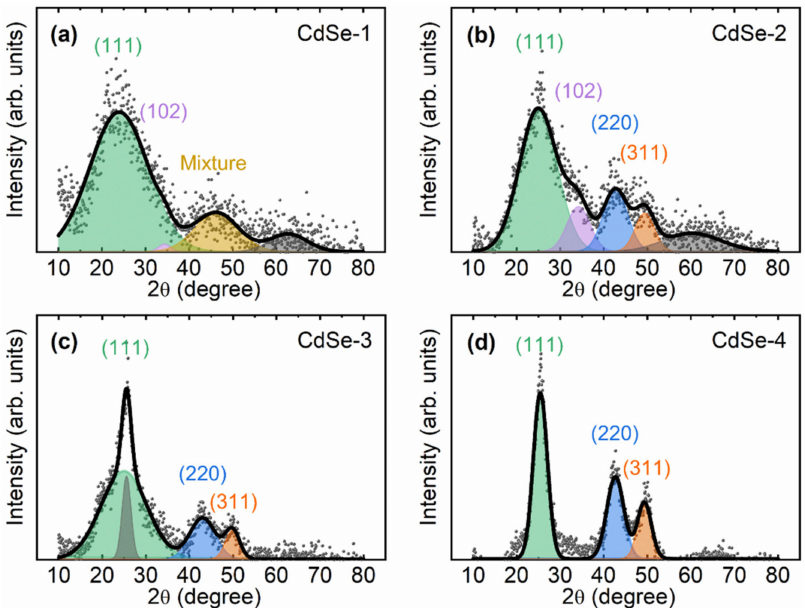
Figure 2. ( a – d ) XRD patterns of CdSe QDs: total fitting curve (black solid line) and fitting curves for each XRD peak (color-filled lines) corresponding to a crystal